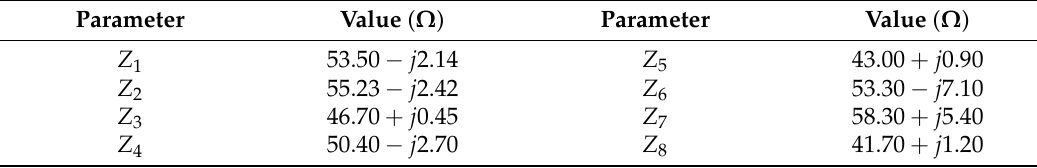
Table 5. Input impedances of array